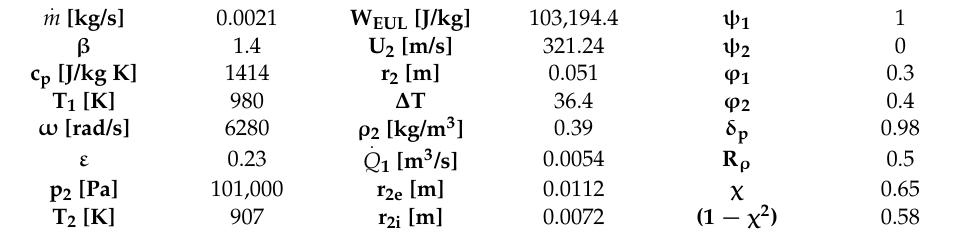
Table 3. Turbine